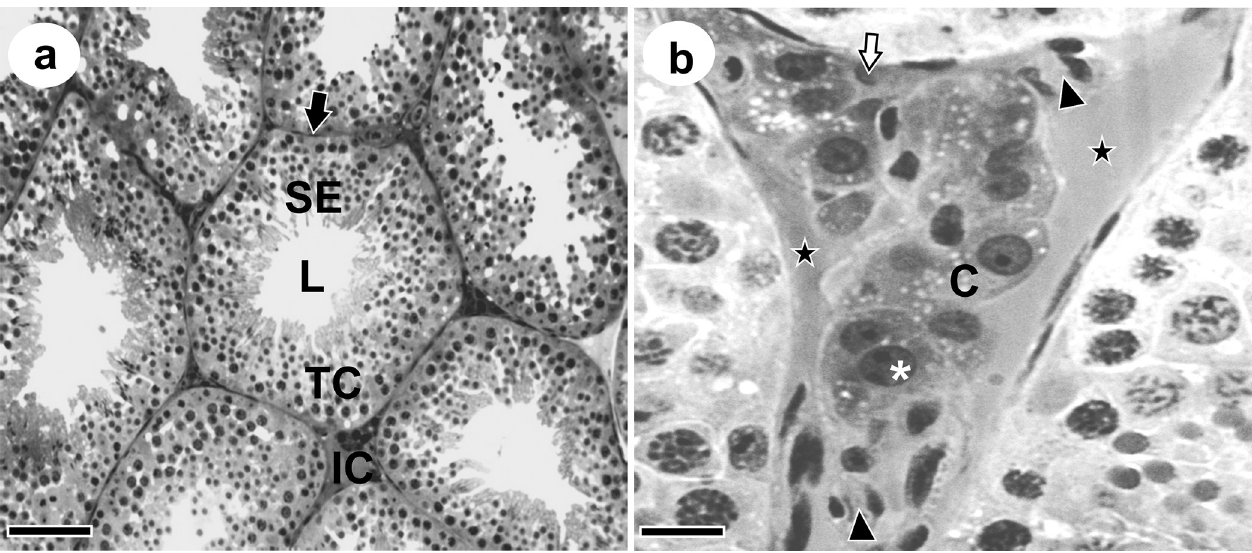
Fig 1. Cross sections of Diphylla ecaudata testis. TC: Tubular Compartment; SE: Seminiferous Epithelium; L: Lumen; Black arrow: tunica propria; IC: Intertubular Compartment; � : Leydig cell nucleus; C: Leydig cell cytoplasm; White arrow: Connective tissue; : Lymphatic vessel; ► :Blood vessel. Scale Bars: a: 30 μ m, b: 10 μ m.